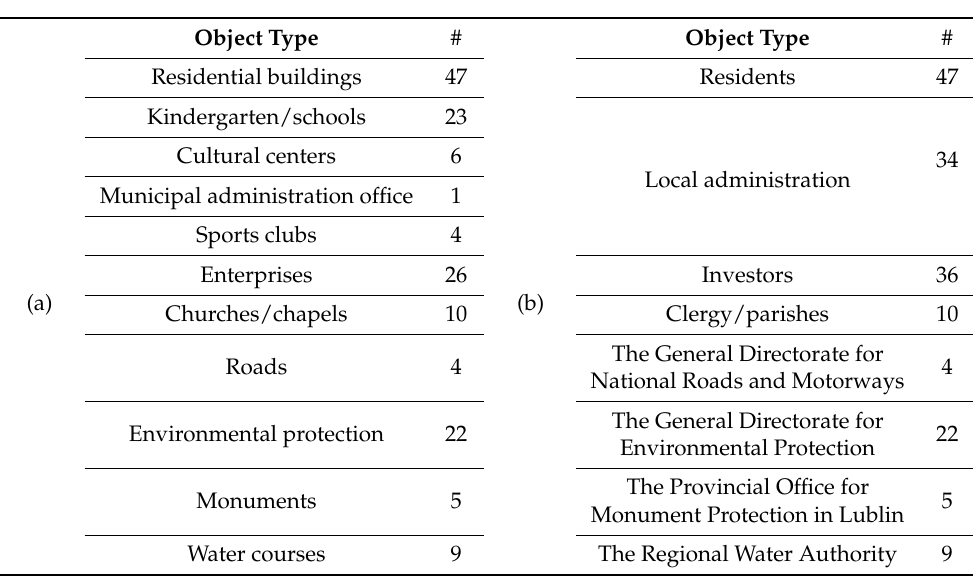
Table 3. The quantitative list of the types of objects (a) and hosts (b) in the Cyc ó w LW Bogdanka mining